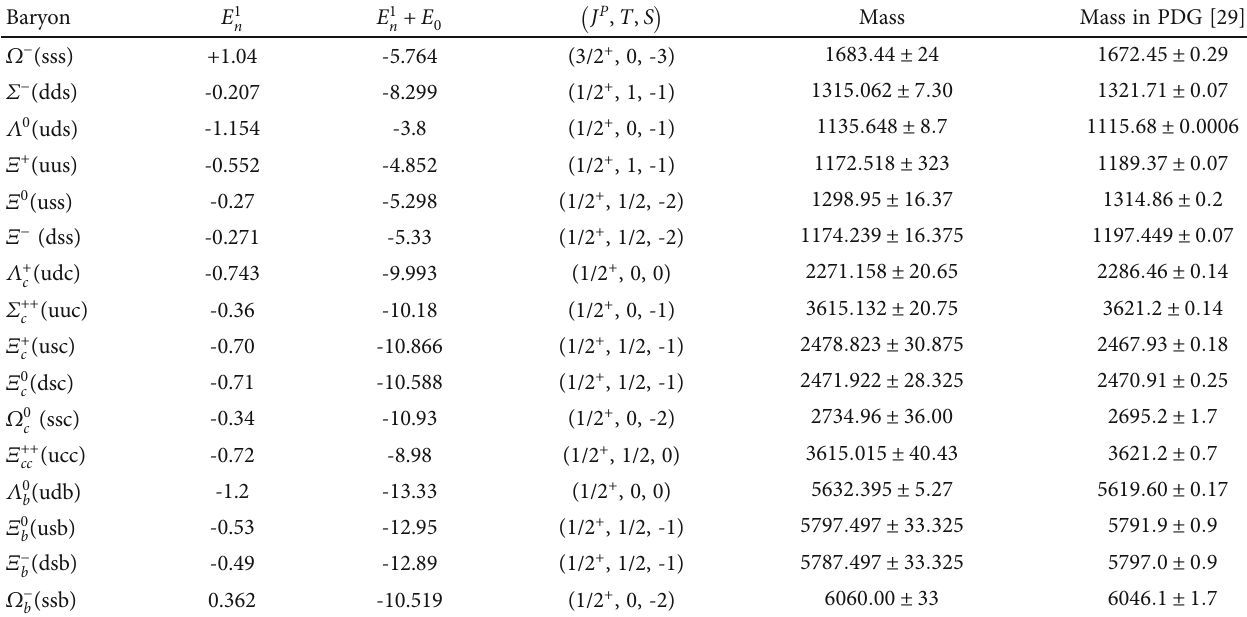
Table 3: Calculated masses (MeV) and energies (MeV) for